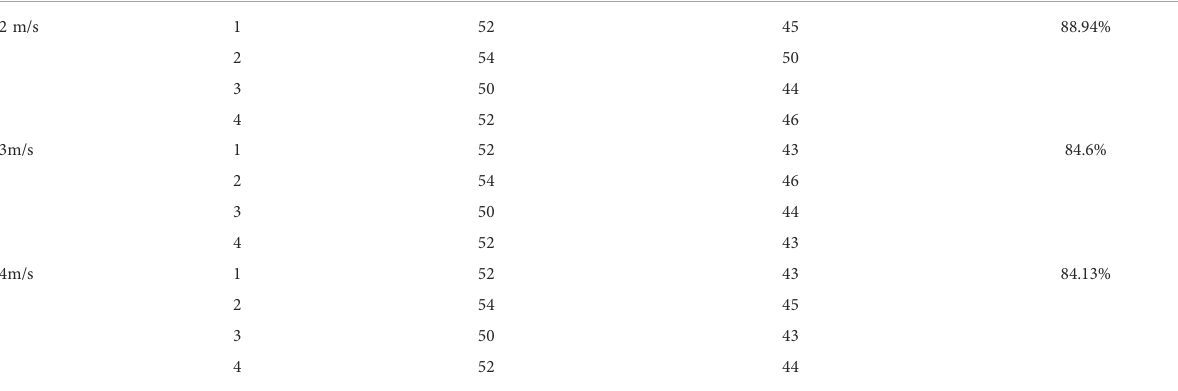
TABLE 3 Detection results of weeds by weeding robot